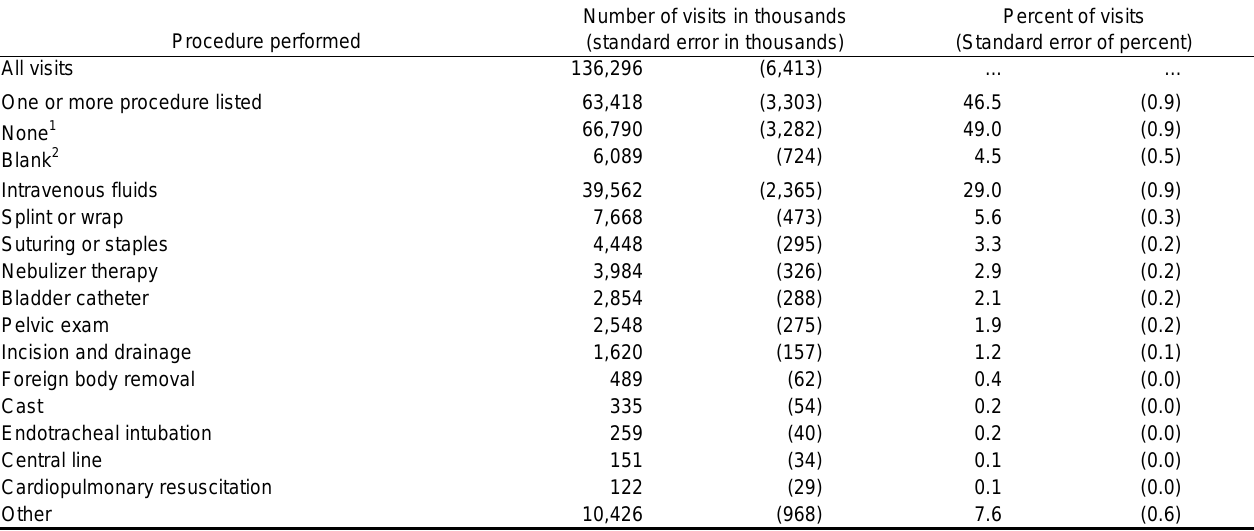
Table 19. Selected procedures at emergency department visits: United States, 2011